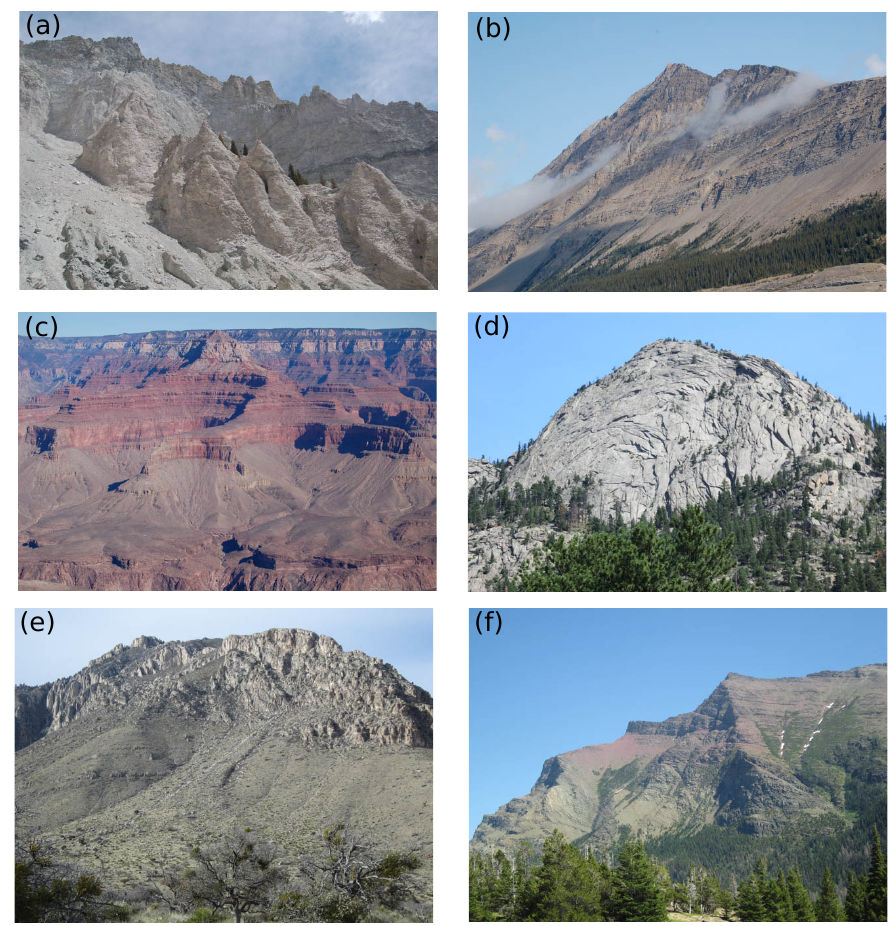
Figure 1. Examples of rocky hillslopes, sometimes referred to as Richter slopes. (a) Chalk Cliffs, Colorado, USA. (b) Canadian Rockies. (c) Grand Canyon, Arizona, USA. (d) Rocky Mountain National Park, Colorado, USA. (e) Guadeloupe Mountains, Texas, USA. (f) Waterton Lakes National Park, Canada (photos by Gregory E.